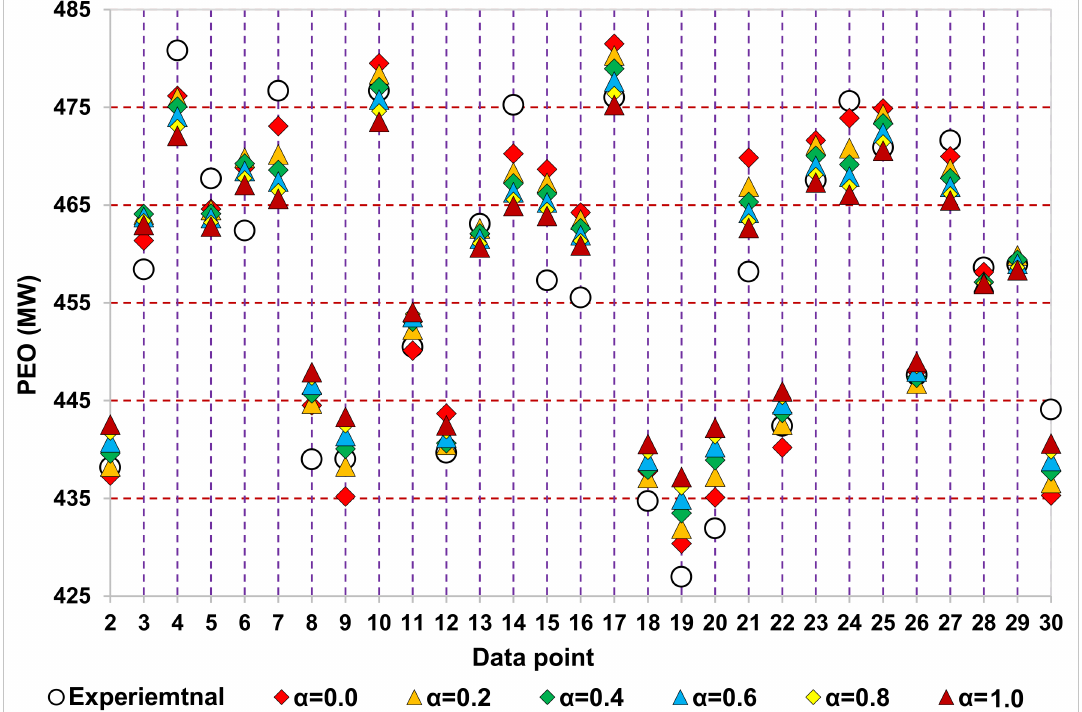
Figure 6. Scatter data plot of predictions by Ridge regressor at different α values during